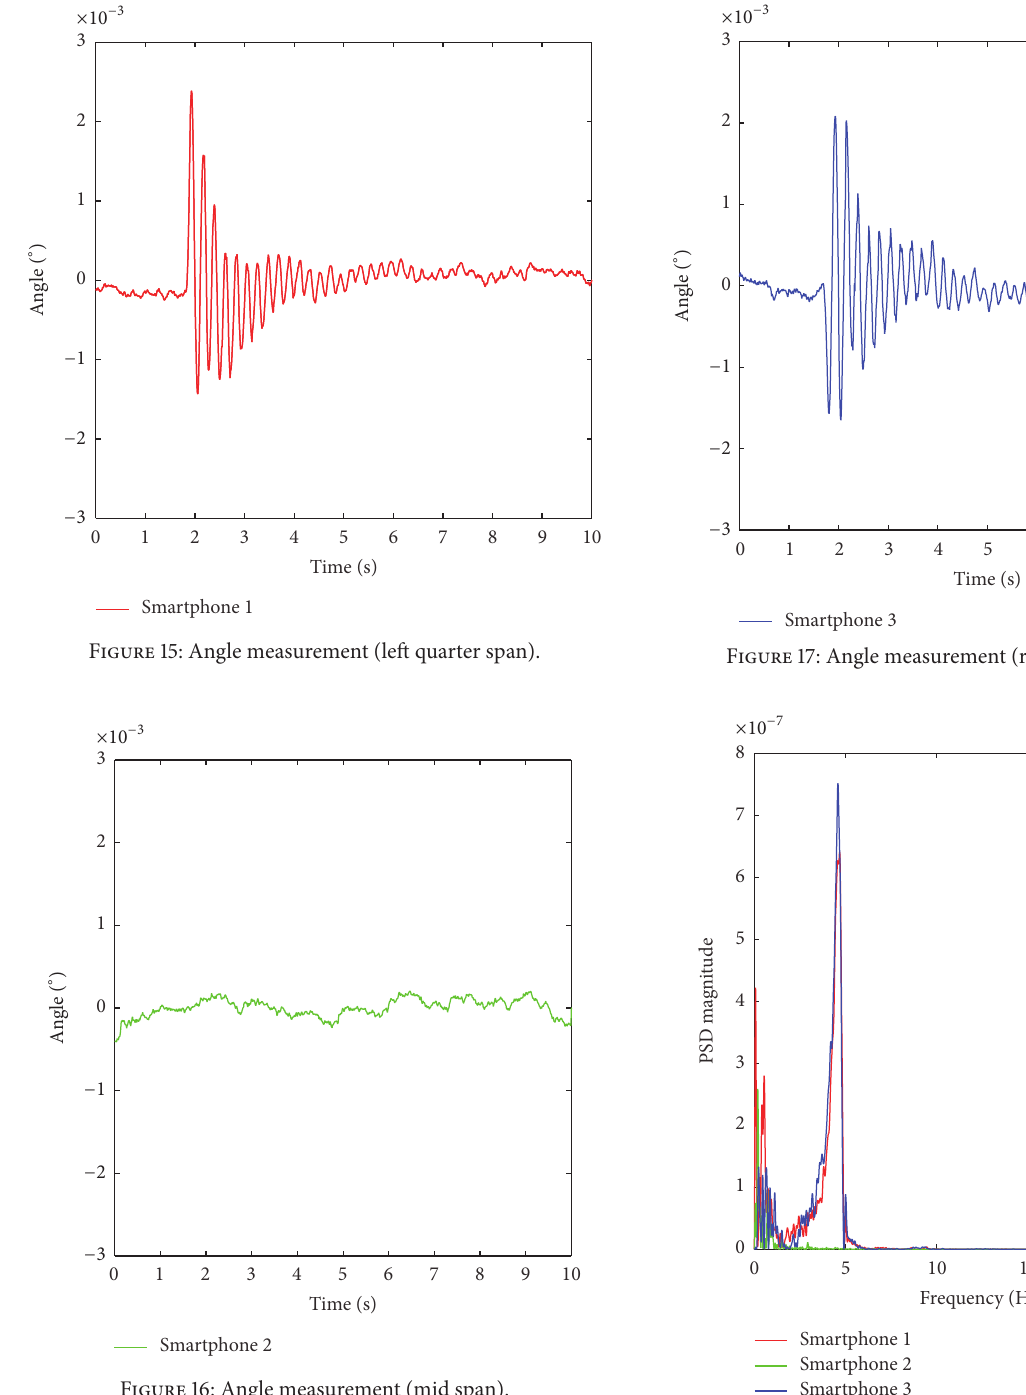
Figure 16: Angle measurement (mid span).